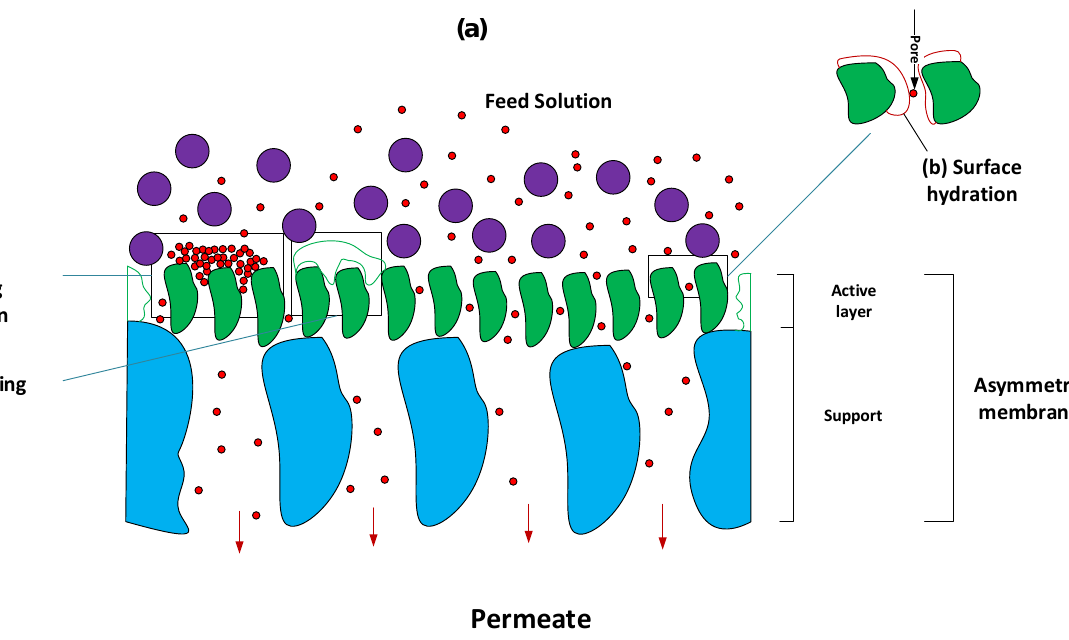
Figure 9. ( a ) Diagram showing numerous processes that occur during membrane separation through the size exclusion mechanism, ( b ) surface hydration (solvent = water), ( c ) fouling, and ( d ) biofouling.